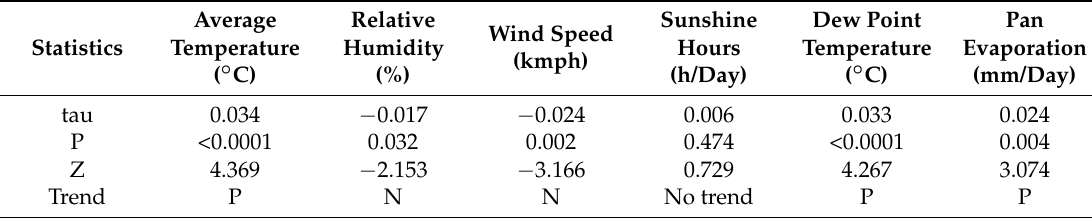
Table 2. Results of trend analysis for Kosice station.